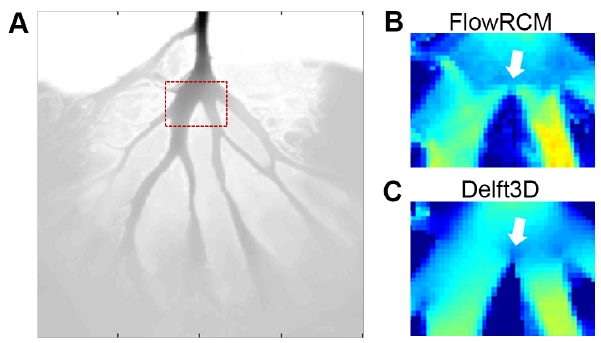
Figure 12. (a) The red dashed square marks one of the regions where FlowRCM displays strong local effects; (b) detailed view from both model results showing the “local effects” in FlowRCM, not present in the Delft3D